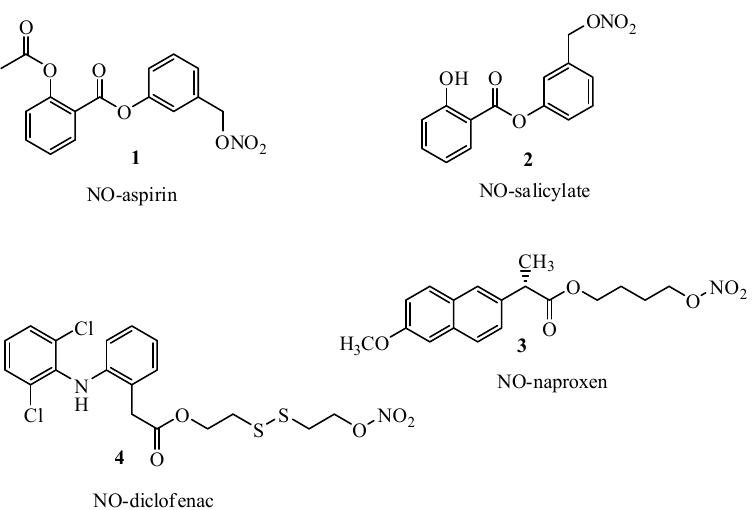
Figure 1. NO-NSAIDs reported in the